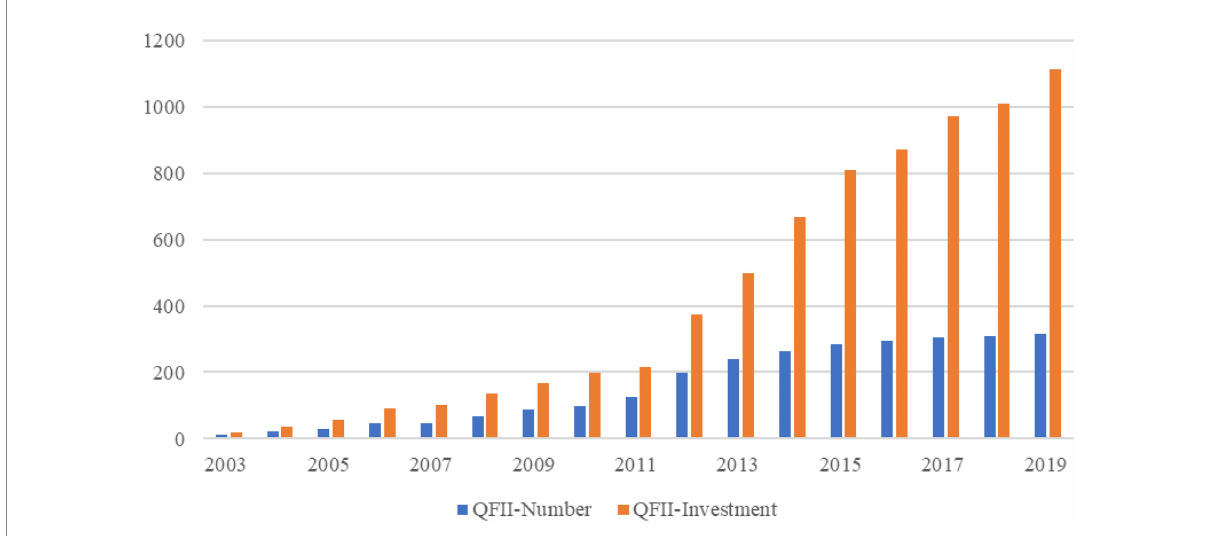
FIGURE 1 Statistics on the number and investment volume of QFII from 2003 to 2019. Remarks: Quantity unit: individual investment unit: billion US